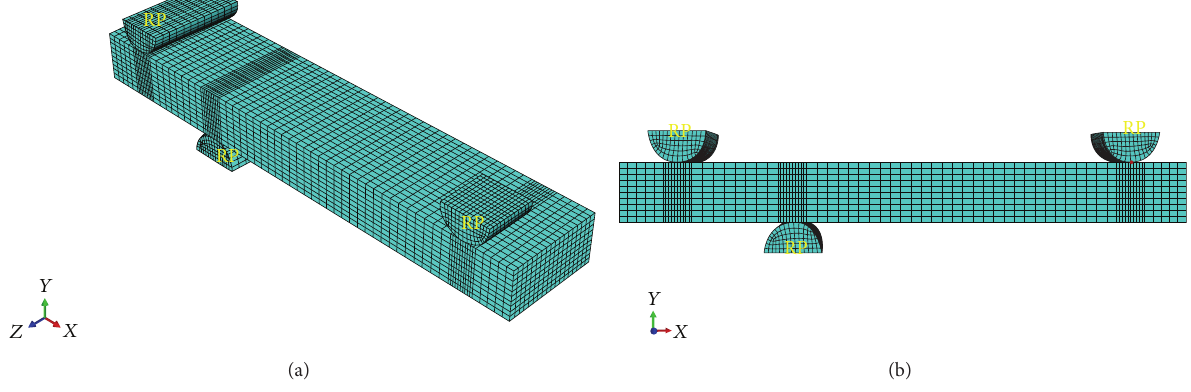
Figure 4: The finite element model for numerical calculations performed in the present study. (a) Model of indentation fatigue; (b) the reference point is highlighted.